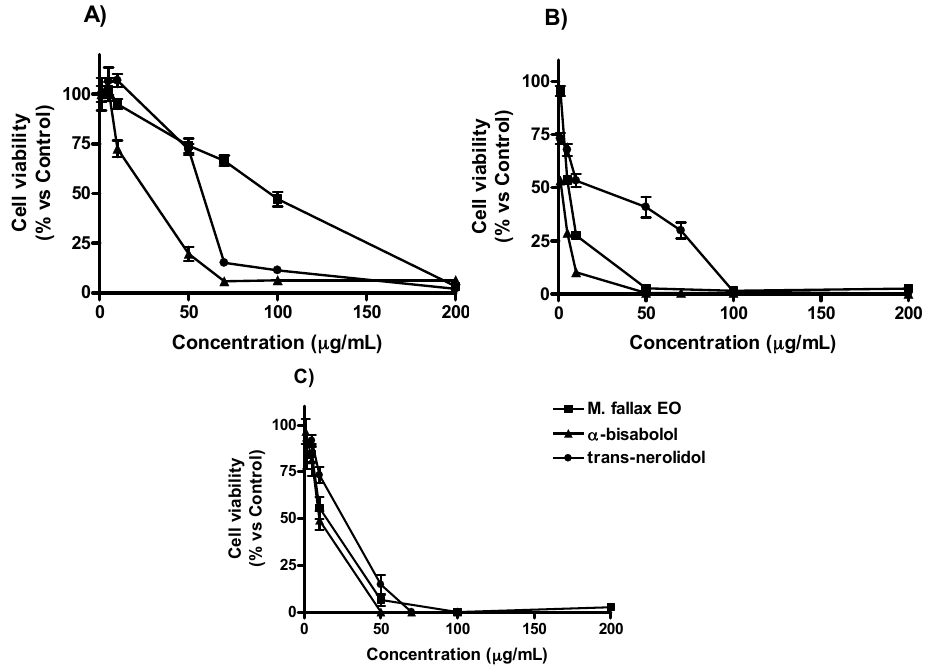
Figure 1. Effects of M. splendens essential oil (EO), α -bisabolol and trans -nerolidol on viability of A549 ( A ), MCF-7 ( B ) and HaCaT ( C ) cell lines. Cytotoxicity was assessed by MTT test after 48 h. Table 2. Cytotoxic activity of M. splendens EO, α -bisabolol and trans -nerolidol on three cell lines after 48 h.